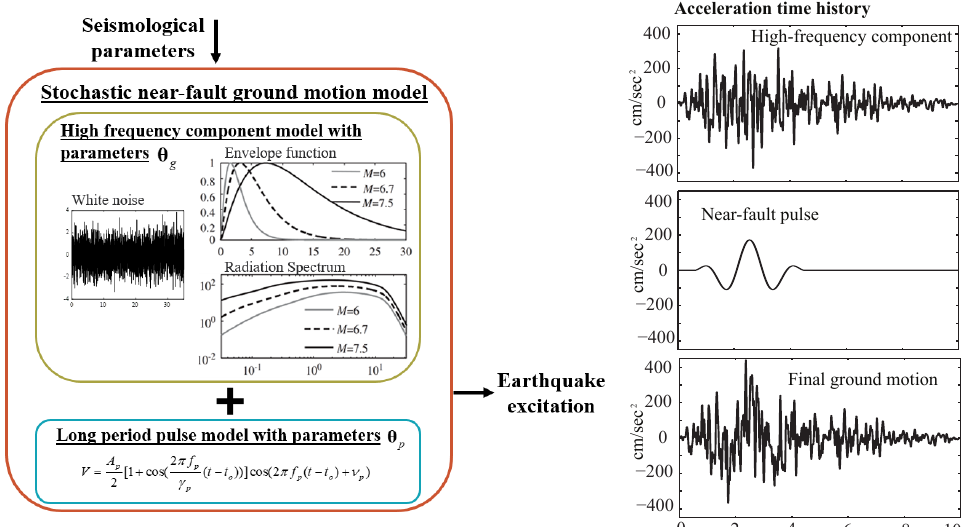
Figure 2. Illustration of the stochastic near-fault ground motion model and sample ground motion time